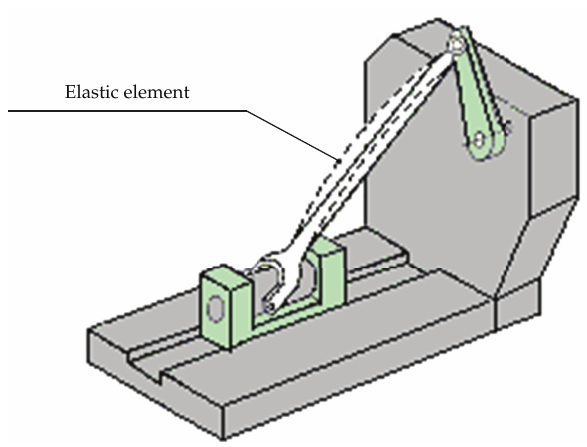
Figure 1: Mechanical system with elastic elements (cid:4) 1 (cid:5)